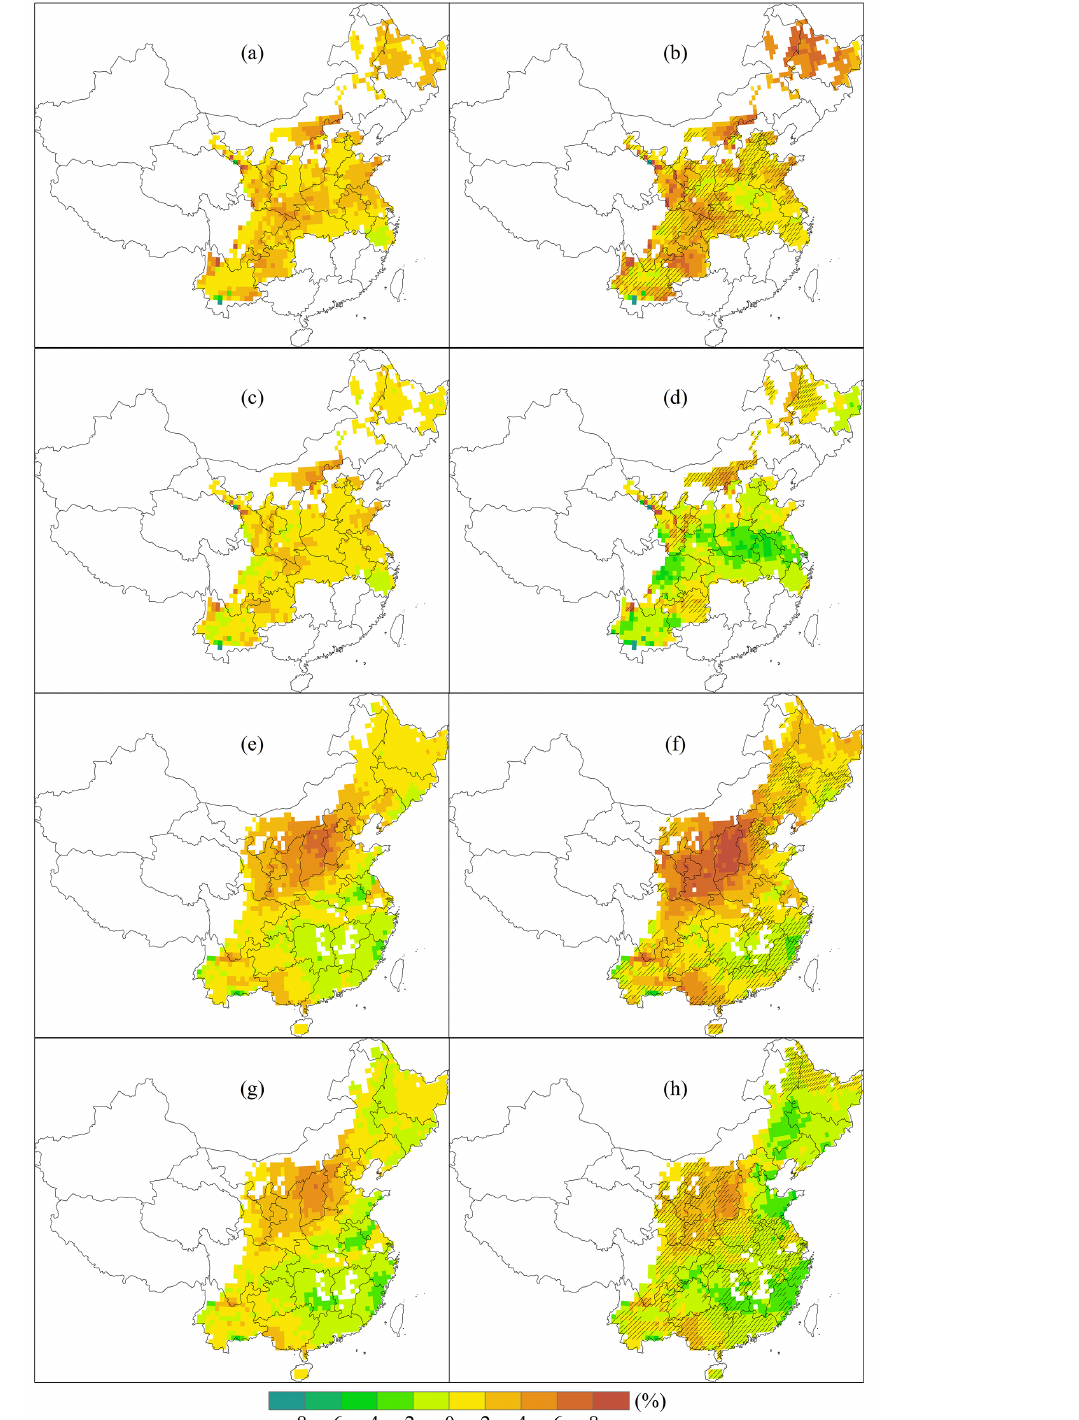
Figure 8. Median changes in yield loss caused by drought stress for wheat (a–d) and maize (e–h) during 2106–2115 under the 1.5 ◦ C warming (a, c, e, g) and 2.0 ◦ C warming scenarios (b, d, f, h) relative to 2006–2015, without (a, b, e, f) and with (c, d, g, h) the CO 2 fertilization effect. Hatching indicates the areas where differences between the 1.5 and 2.0 ◦ C warming scenarios are not significant ( P > 0 .